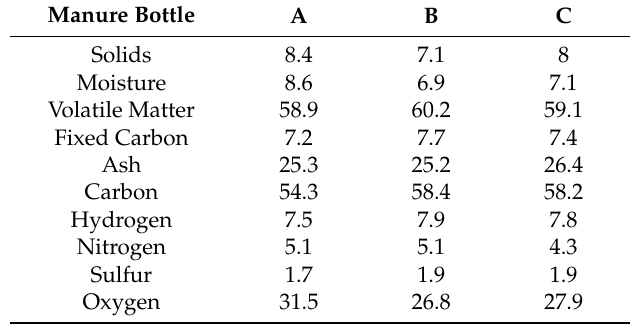
Table 1. Chemical composition (wt %) of the feedstock (swine manure) on a dry, ash-free basis.